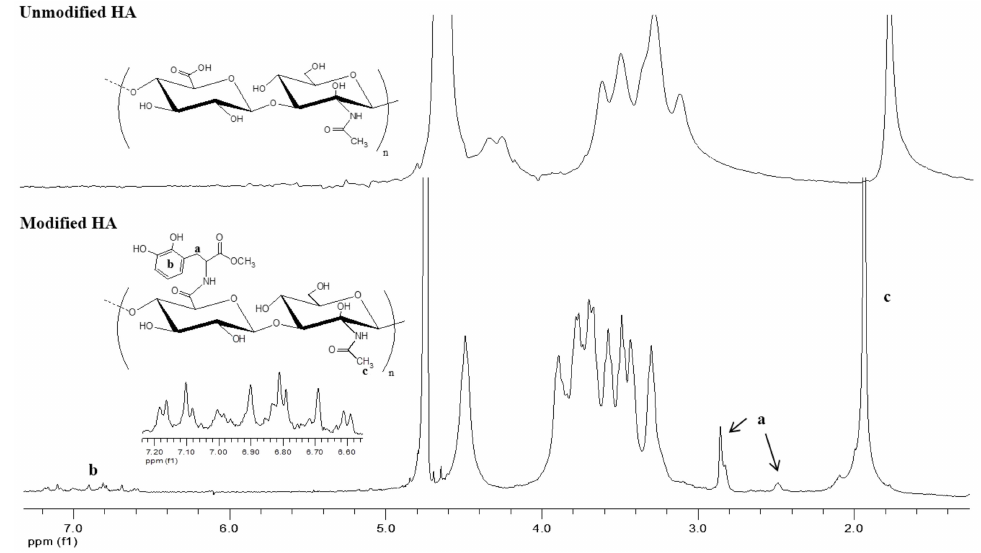
Figure 4. 1 H NMR of hyaluronic acid–catechol (modified HA) versus unmodified hyaluronic acid (HA) in D 2 O.